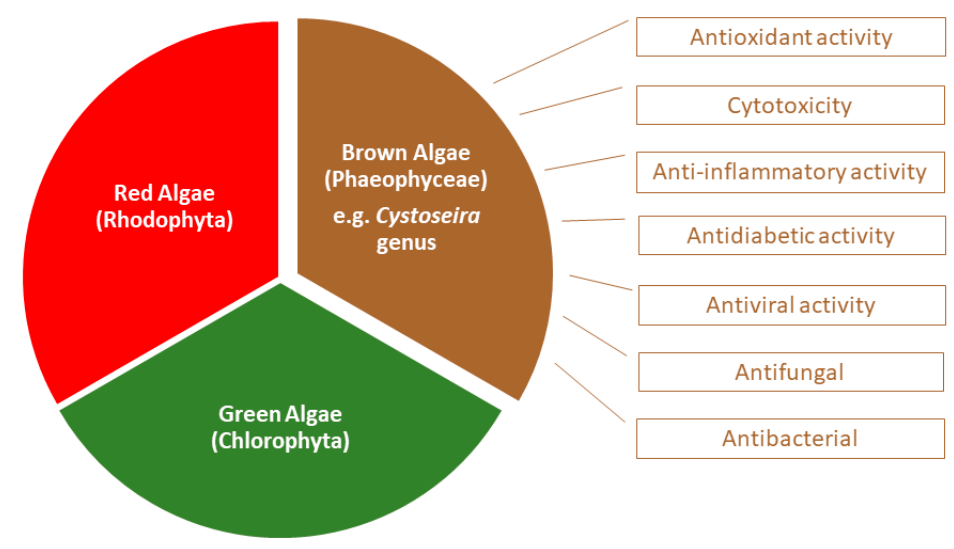
Figure 1. Biological activities associated to Cystoseira , an important genus belonging to the group of brown algae.